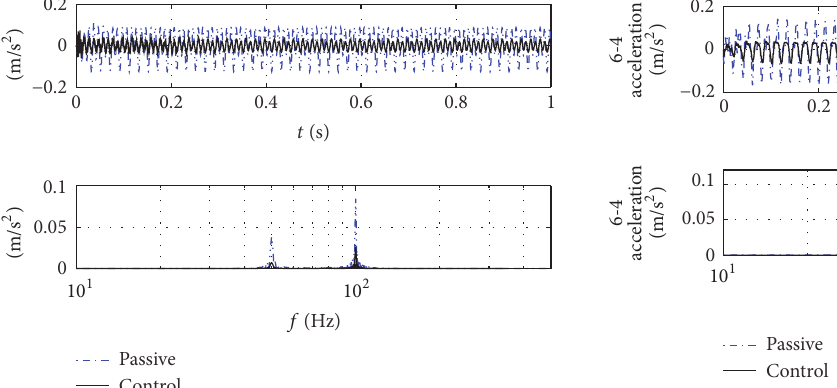
Figure 15: Comparison time-frequency domain curves of accelera- tion response of position 6-4 on the isolation system before and after being controlled under double sinusoidal